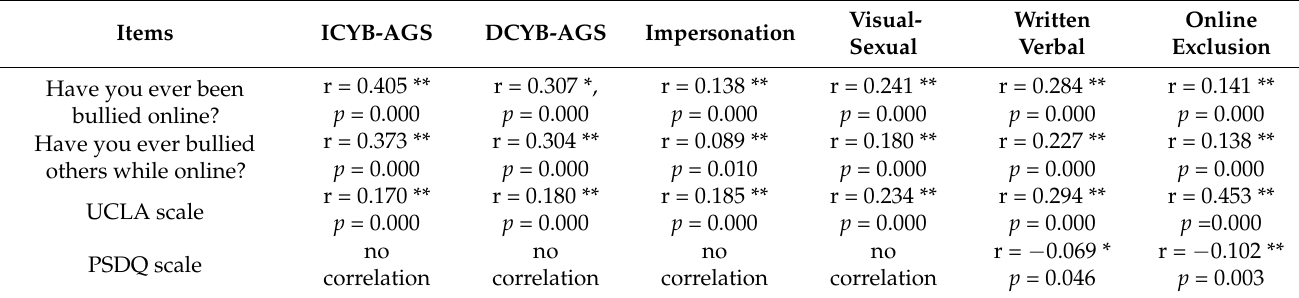
Table 5. Correlational results of CYB-AGS and CYVIC